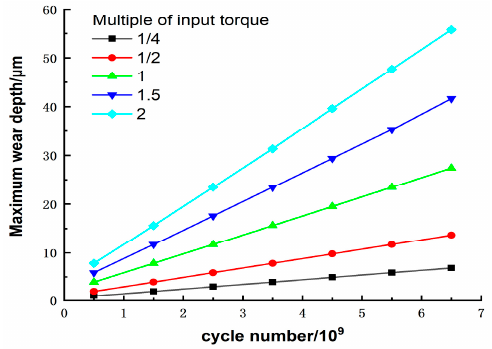
Figure 14. Effect of torque on maximum wear depth.